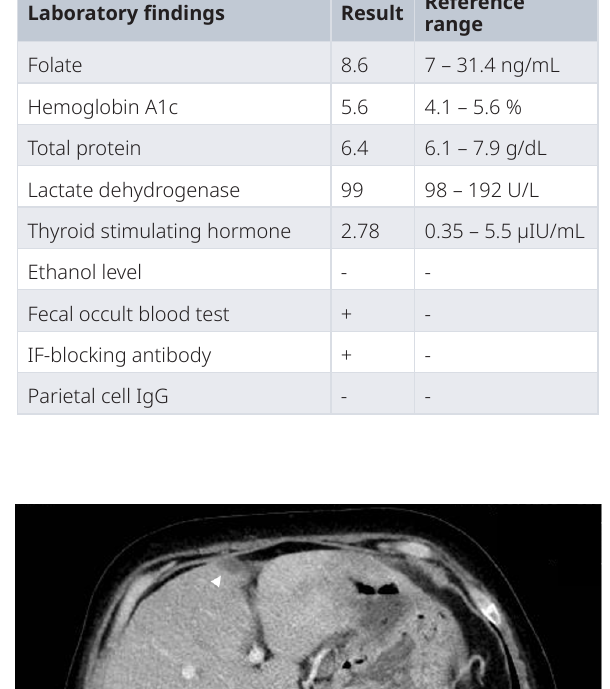
Figure 2. EGD demonstrates esophagitis and an extensive ulcer involving the entire lesser curvature of the stomach. (From proximal to distal.) ( A ) Esophagitis. ( B ) Gastro-esophageal junction. ( C ) More esophagitis, and a tongue of columnar mucosa. ( D ) Normal gastric cardia. ( E ) Normal gastric fundus. ( F ) Cavernous ulcer along the incisura (lesser curvature) with debris, food particles, and some central exudates ( G ) Continued ulcer description. At the 12 o’clock position the scope is originating from the gastric cardia and fundus region. At 3 o’clock is the expected location of the pylorus. However, due to size and extent of the ulcer typical anatomy and landmarks were considerably distorted making visualization of the fundus from that particular EGD position not possible. At 6 o’clock the ulcer is shown to extend along the incisura. At 9 o’clock food debris is seen along the greater curvature.